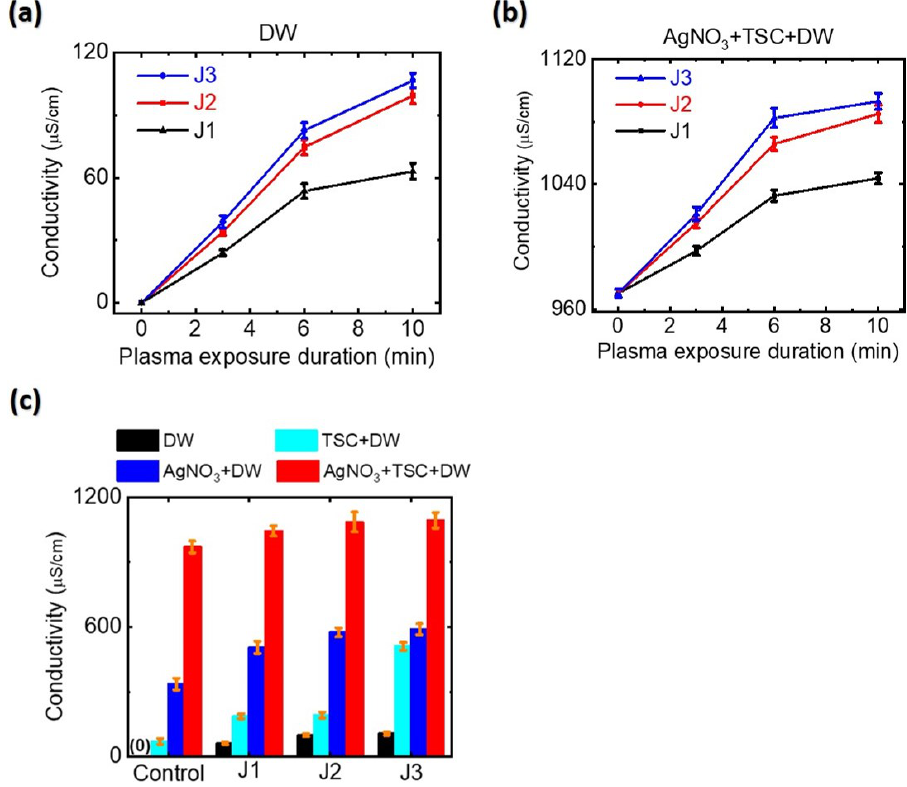
Figure 5. Electrical conductivies of ( a ) plasma-treated-DW and ( b ) plasma-treated AgNO 3 -TSC-DW as a function of plasma exposure duration. ( c ) Electrical conductivies of DW, TSC-DW, AgNO 3 - DW, and AgNO 3 -TSC-DW treated for 10 min with the J1, J2, and J3 jets. In Figure ( c ), the electrical conductivity of plasma-untreated DW was 0 µ S/cm.